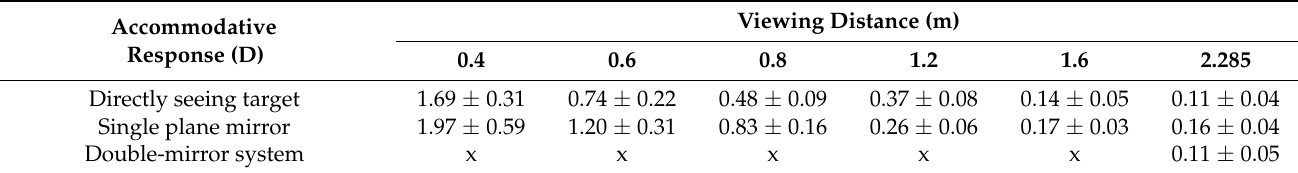
Table 2. The accommodative response varies with the viewing distance in the different ways.